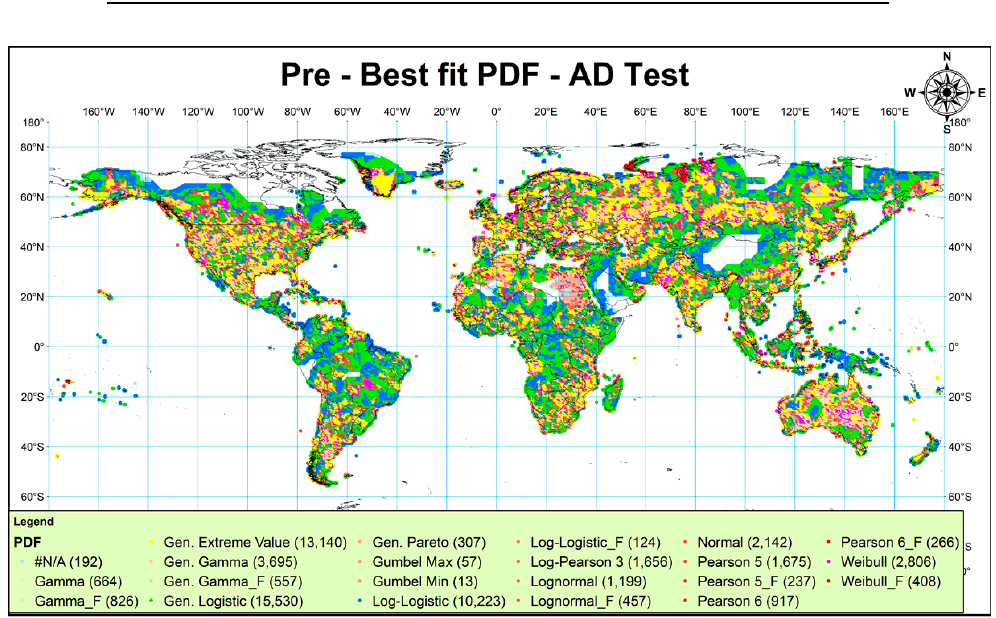
Figure 5. Best-fit probability distributions for annual precipitation by Anderson–Darling (AD) test. PDF: probability distribution function.